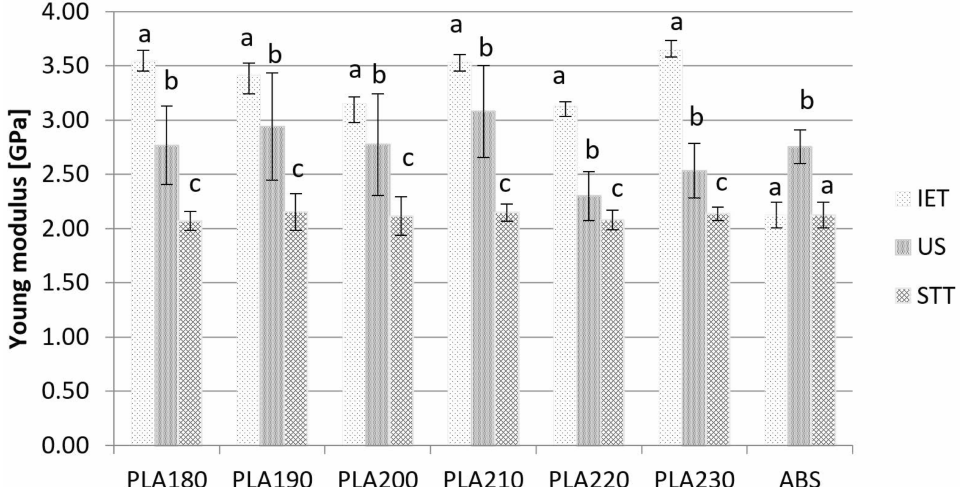
Figure 6. A comparison of statistical differences between Young’s modulus values calculated usingthe static tensile test and the analyzed non-destructive methods of determining Young’s modulus (STT, US and IET). Bars with the different letters (a, b, c) are significantly